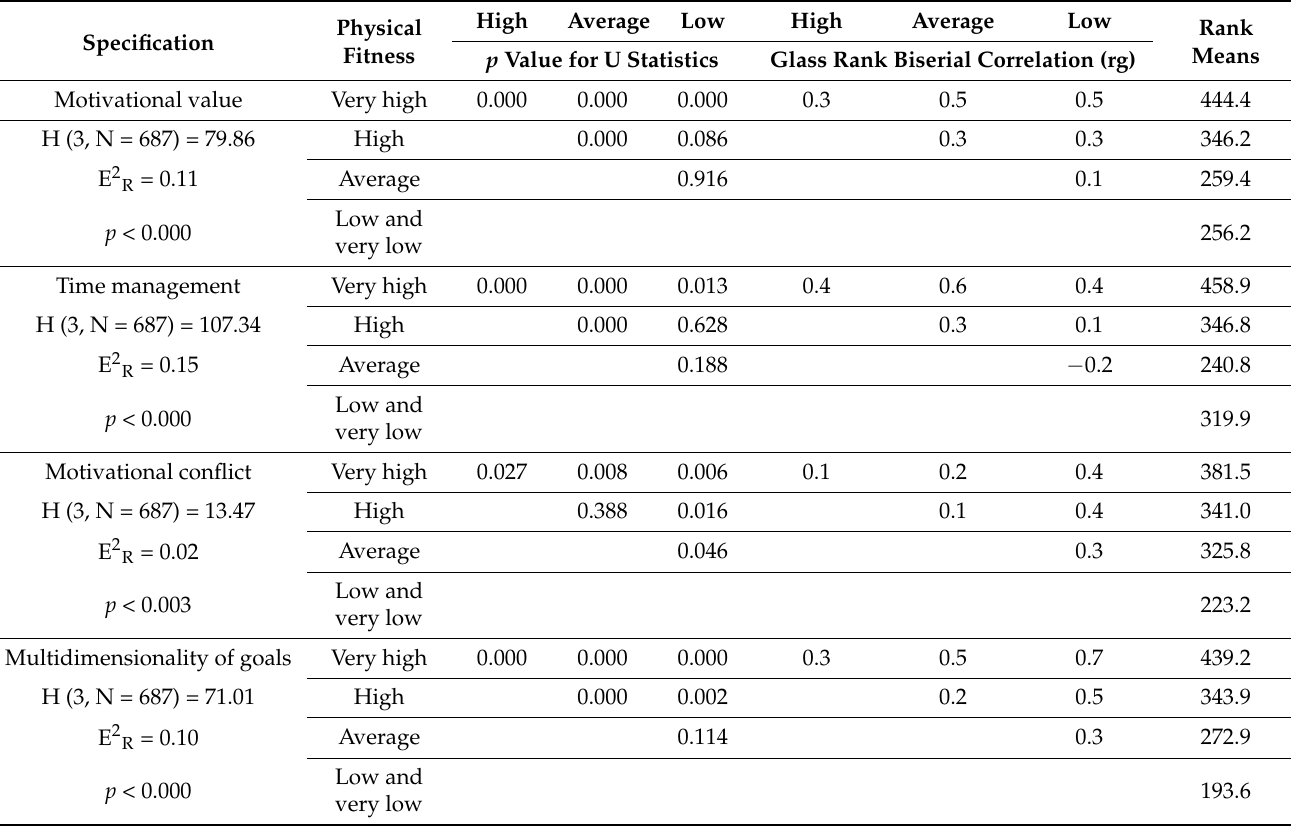
Table 4. Motivational functions of physical activity goals (IPAO), depending on the self-assessment of physical fitness of the respondents (H test, E 2 R, U test,